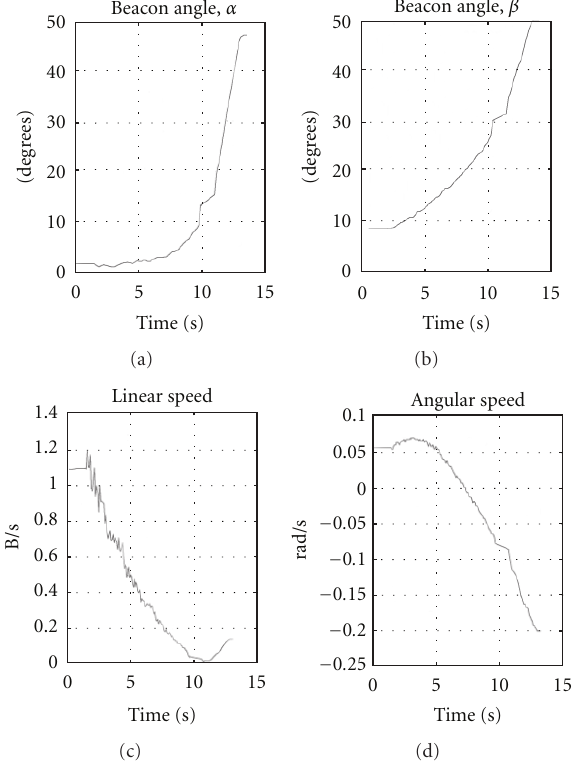
Figure 15: The changes in α , β , and the control signals for the second experiment.